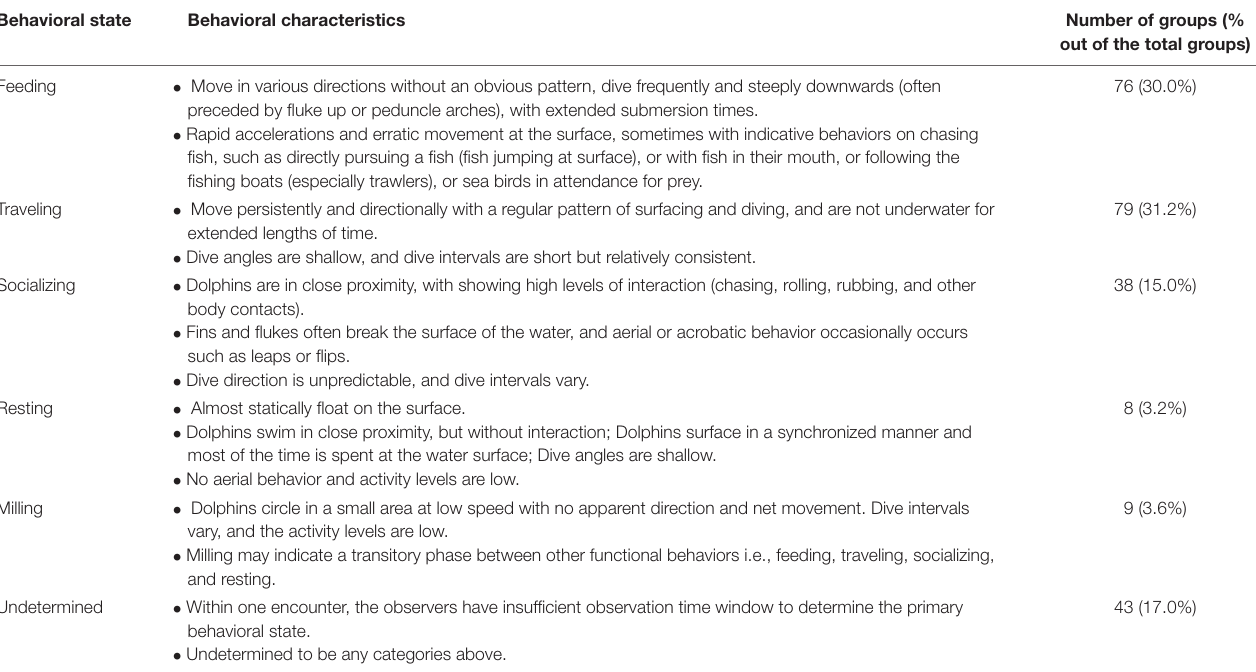
out of the total groups)